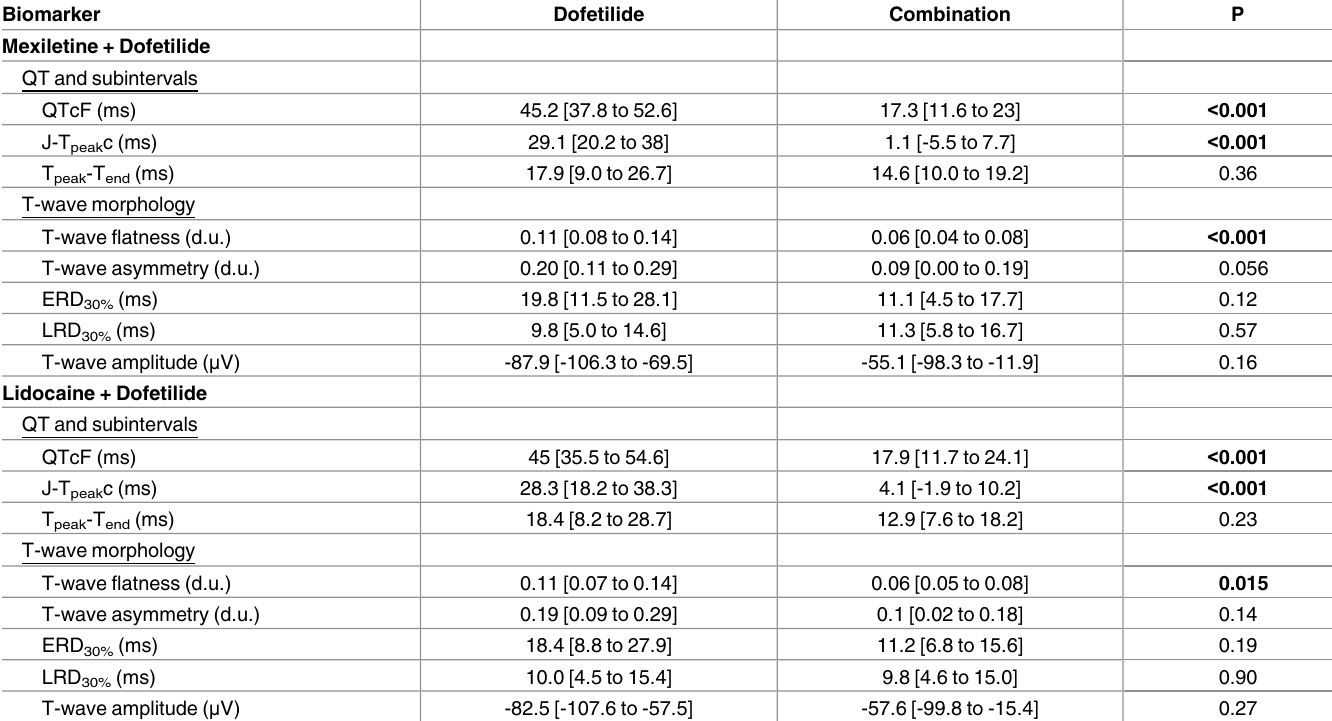
Table 3. Placebo- and baseline-corrected drug-induced ECG changes at Tmax. Biomarker